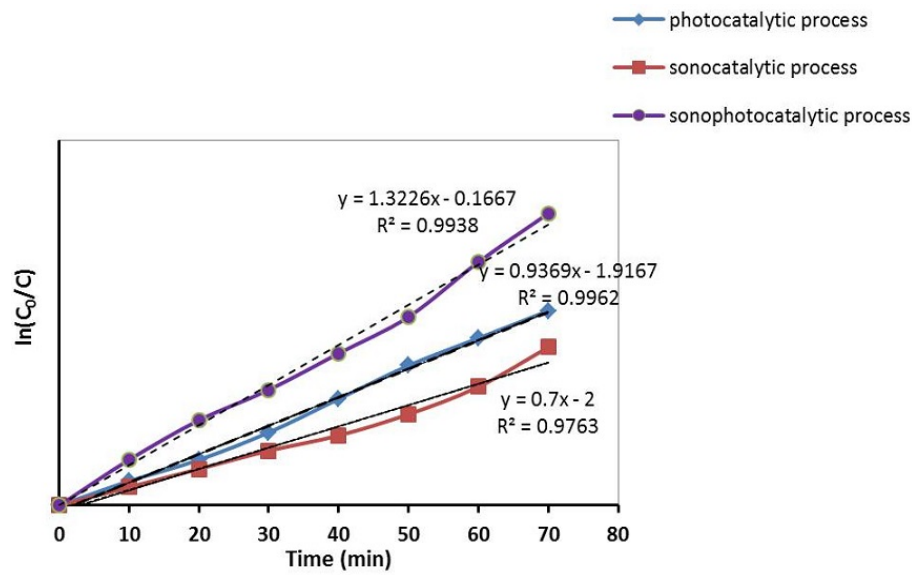
Figure 11. First-order kinetic plot for sono-photocatalytic, sonocatalytic and photocatalytic processes, [Dye] = 20 mg/L, [Catalyst] = 1.25 g/L, pH = 6.